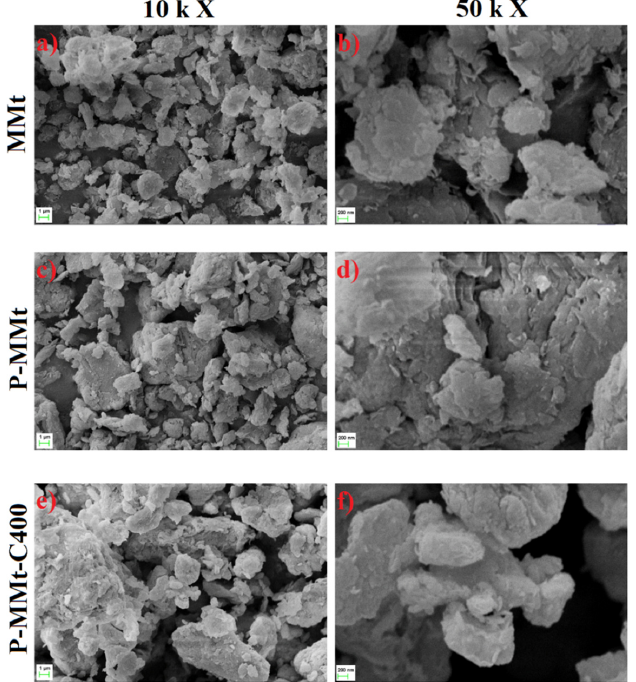
Figure 6. Surface structure and particle size of ( a , b ) MMt, ( c , d ) P-MMt, and ( e , f ) P-MMt-C400 in the field emission scanning electron microscope (FE-SEM) images.